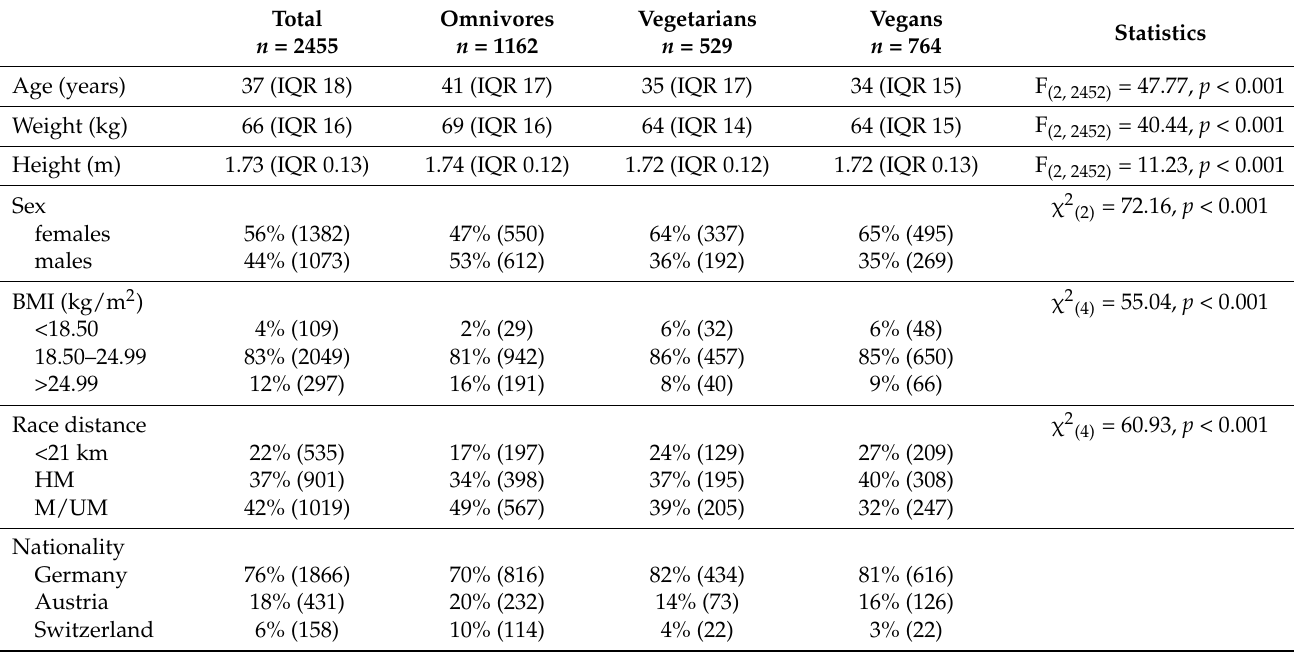
Table 1. Sociodemographic characteristics of participants presented by dietary